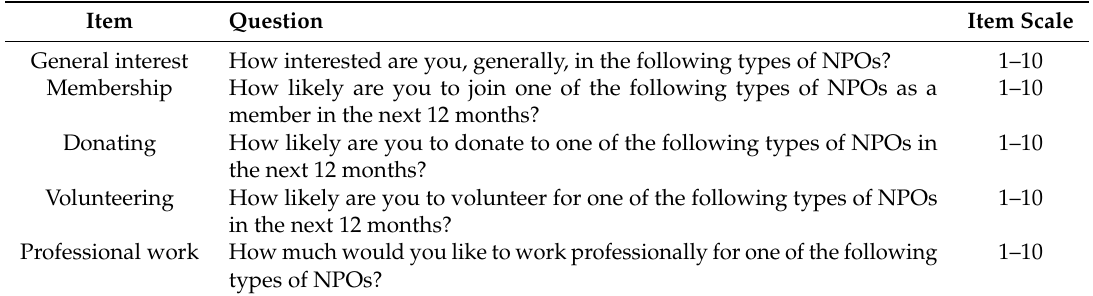
Table 1. Operationalization of attitudes towards